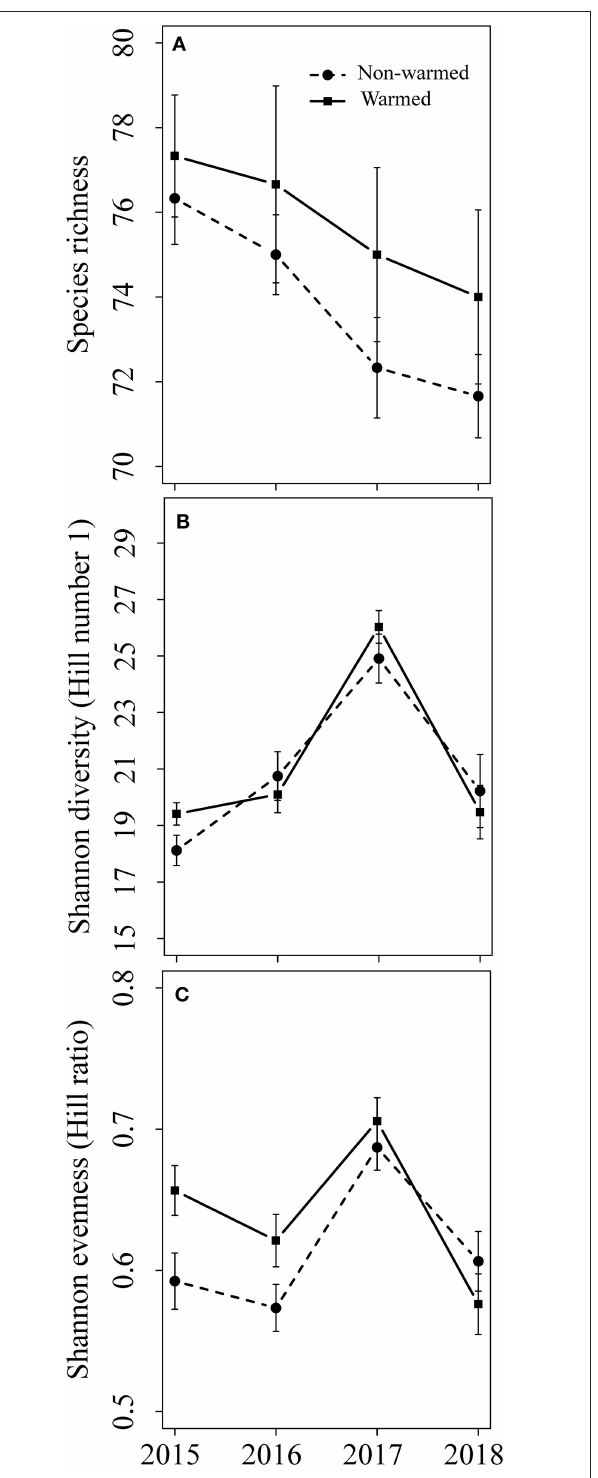
FIGURE 2 | Plant species diversity in both non-warmed and warmed chambers from 2015 to 2018. (A) Species richness; (B) Shannon diversity (Hill number 1); (C) Shannon evenness (Hill ratio). No significant difference in each variable was found between non-warmed and warmed chambers for each study